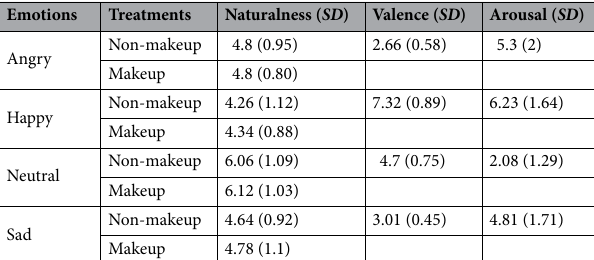
Table 2. Descriptive statistics of materials in Experiment 1 ( M and SD